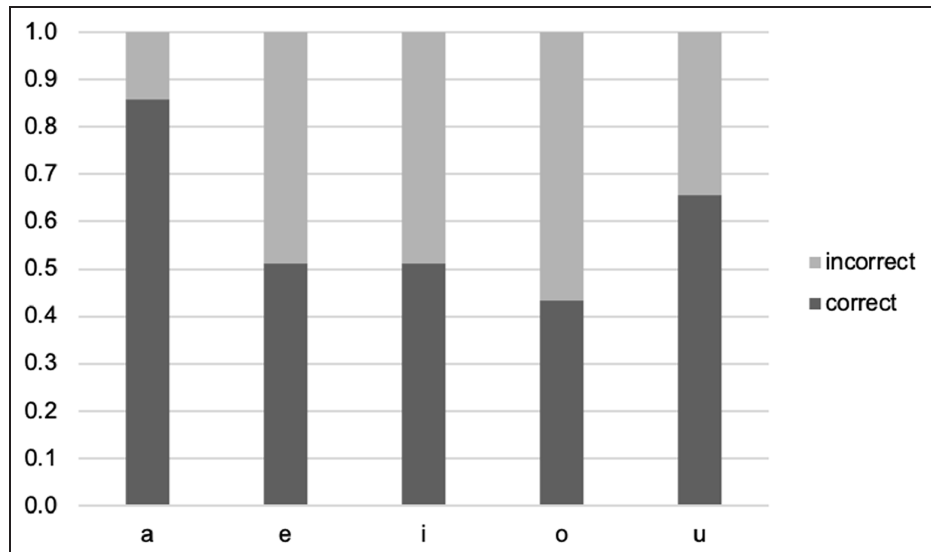
Figure 8: Overall ratings accuracy by vowel